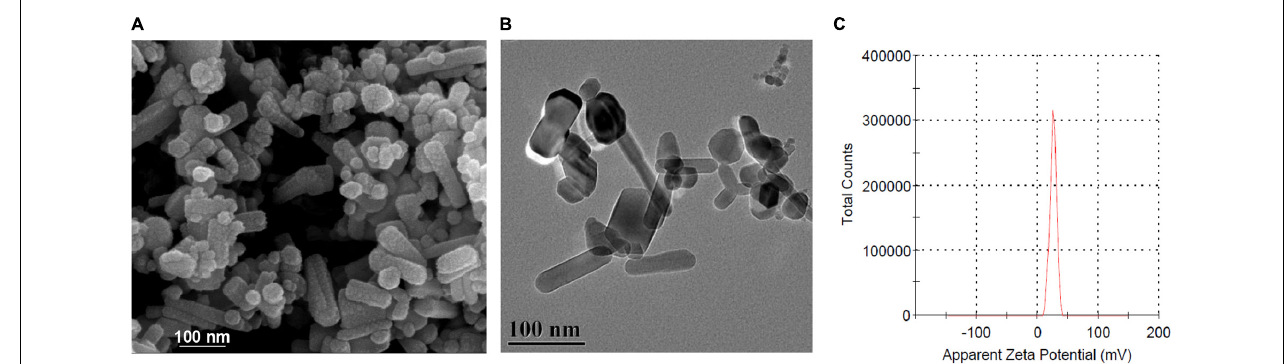
FIGURE 1 | Characterization of zinc oxide nanoparticles (ZnO-NPs). (A) Scanning electron microscopy (SEM) and (B) high-resolution transmission electron microscope (HRTEM) showing the morphology of ZnO-NPs. Scale bar, 100 µ m. (C) Zeta potential of